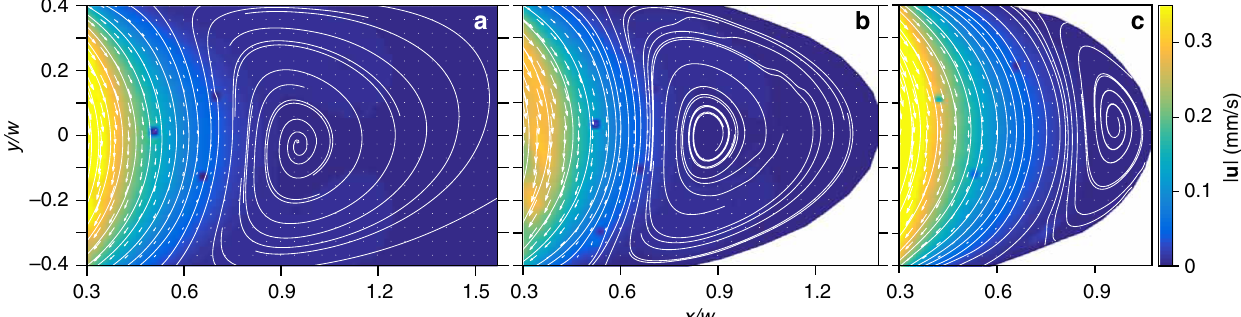
Fig. 3 Velocity fi eld obtained from micro-particle image velocimetry for different eccentricities. Color map of fl uid velocity magnitude | u | obtained by μ PIV in the cavity region for a e → 1, Re = 0.07; b e = 0.95, Re = 0.08; and c e = 0.9, Re = 0.07. Velocity fi eld and streamlines are shown by arrows and lines,